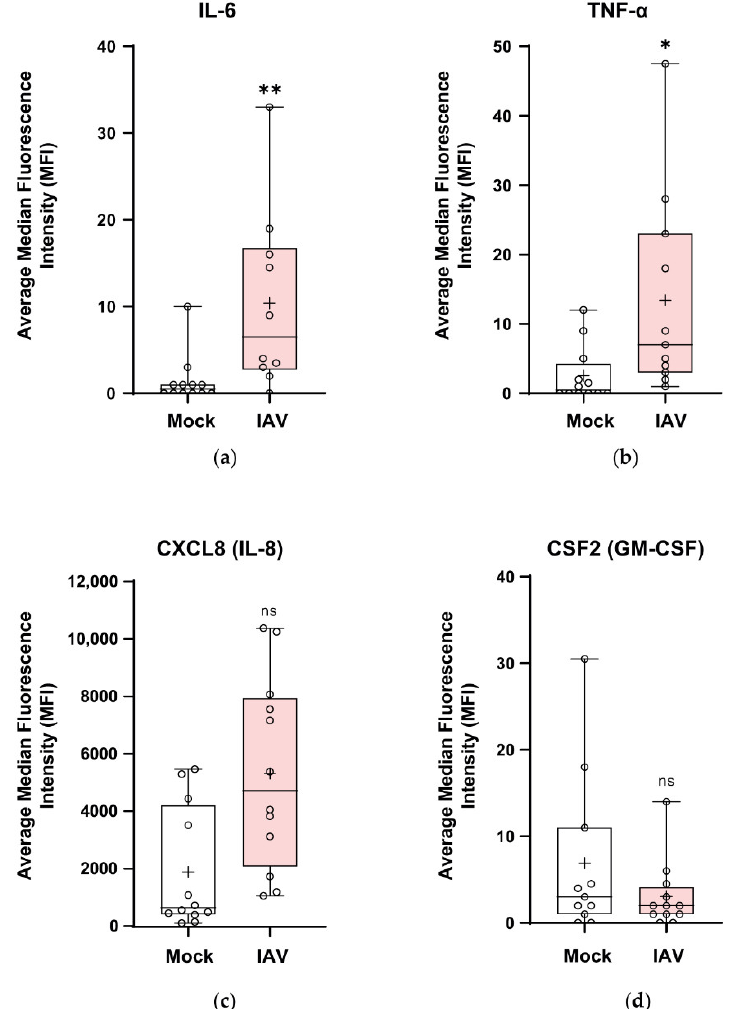
Figure 7. The apical secretion of cytokine and chemokines by wdNHBE cells in response to infection with IAV H1N1pdm09. At 30 h postinfection, the proinflammatory cytokines IL-6, TNF- α , CSF2 and the CXCL8 chemokine secreted into the apical compartment by wdNHBE inoculated with H1N1pdm09 or mock-infected were assayed by multiplex immunoassays. ( a ) IL-6, ( b ) TNF- α , ( c ) CXCL8 and ( d ) CSF2. ALI media was added to the upper surface and the supernatant collected after a 15 min incubation. Data was pooled from three independent experiments and the average of the median fluorescence intensity (MFI) presented as box and whisker plots showing the mean ( + ), median, interquartile range and maximum and minimum values. The ends of each box represent the upper and lower quartiles, the horizontal line within the box shows the median value and error bars indicate the minimum and maximum values. Individual values are depicted by open circles. IAV apical cytokines: n = 12 for all treatments, with the exception of IAV, IL-6 ( n = 10); IAV TNF- α ( n = 11) and Mock CSF2 ( n = 11); ns, not significant; *, p < 0.05; **, p < 0.01.